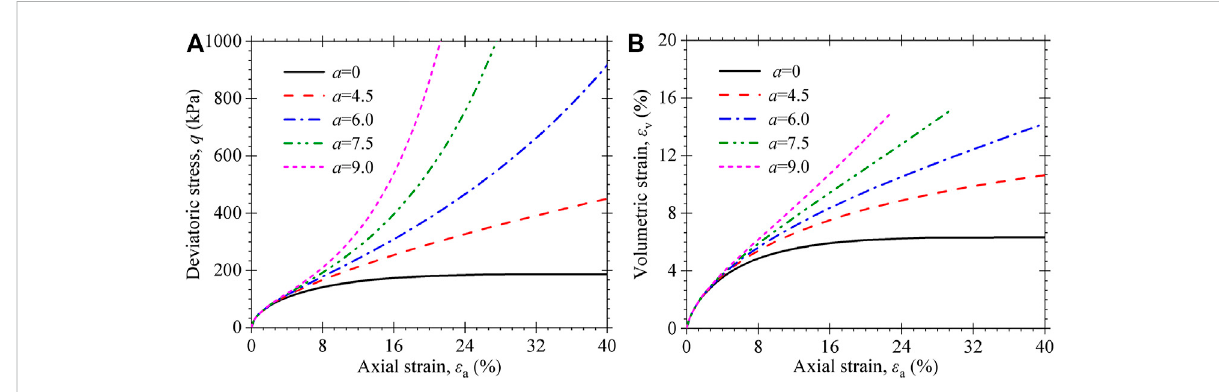
In fl uence of parameter a on the stress – strain behavior of MSW: (A) stress – strain curves; (B) volumetric strain vs. axial strain curves.